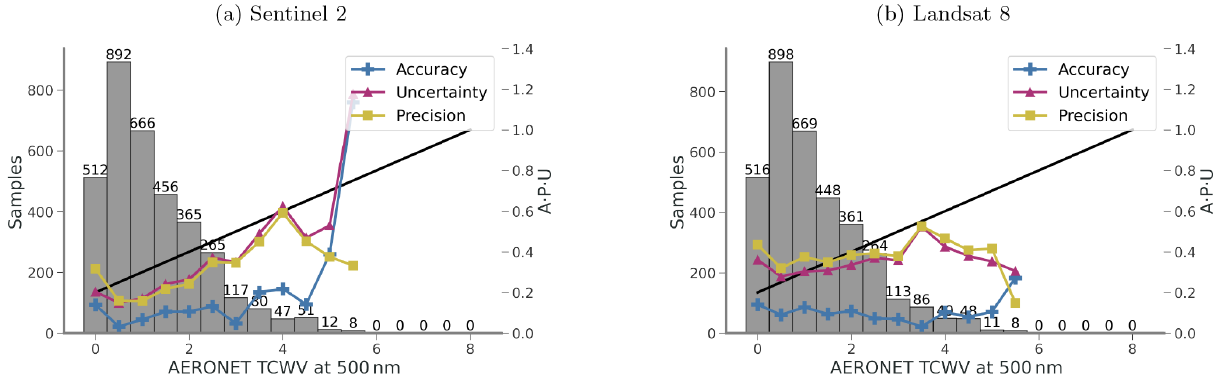
Figure 7. The accuracy ( A ) (plus marker), precision ( P ) (square marker), and uncertainty ( U ) (triangle marker) validation of TCWV against AERONET measurements. Threshold uncertainty is shown as black lines in the